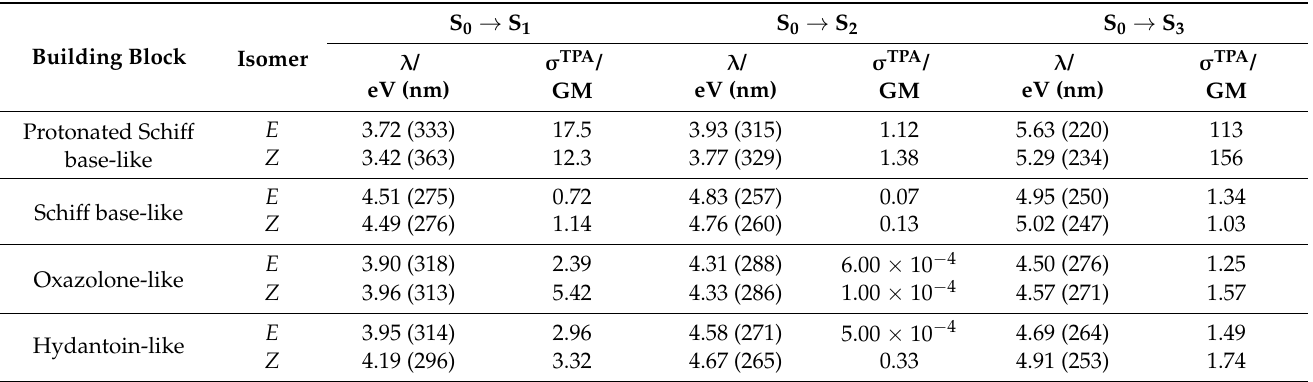
Table 1. Vertical transition energies, calculated as energy difference between the electronic ground state and the selected excited state ( λ ), and TPA cross section values ( σ TPA ) for the different core structures of each photoswitch family studied in this work. S 0 → S 1 , S 0 → S 2 and S 0 → S 3 vertical transitions are considered, calculated at the CAM-B3LYP/6-31+G* level of theory.